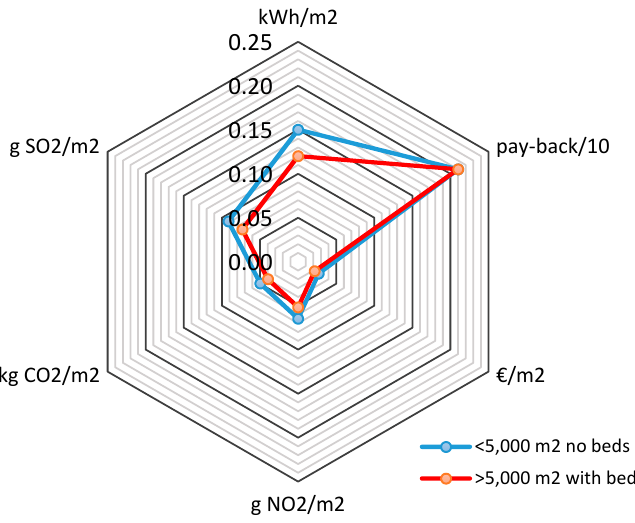
Figure 4. Potential of energy saving derived from optimization of lighting system.